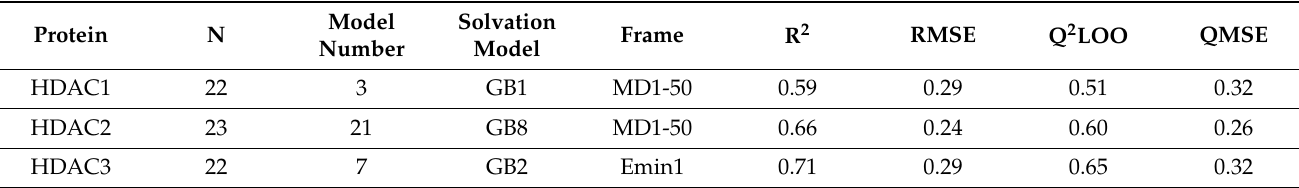
Table 2. Best performing models of HDAC1, HDAC2 and HDAC3.